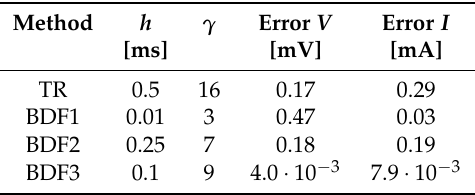
Table 14. Full wave rectifier: Low-precision configuration of DAE integration methods.